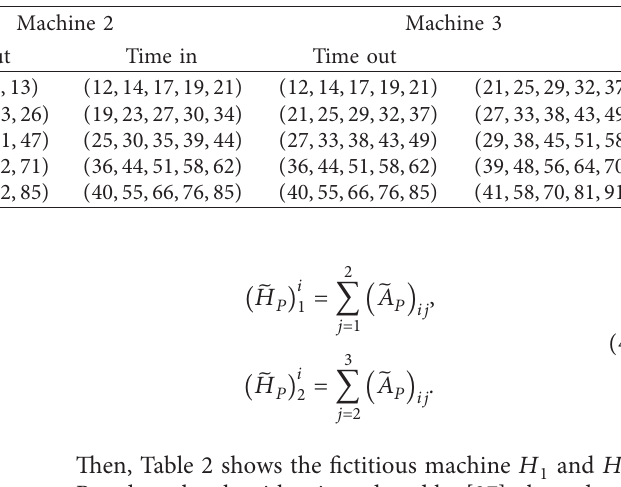
Table 3: Time in and time out for